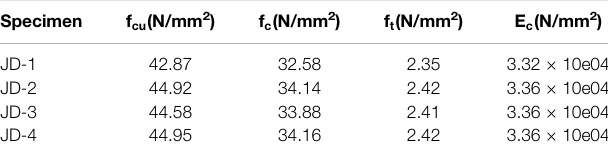
TABLE 3| Mechanical behaviorofconcrete (Xianget al.,2017;Xiang etal., 2019). Specimen